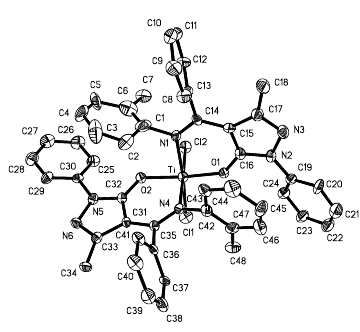
Figure 1. Molecular structure of Ti complex 2 with thermal ellipsoids drawn at the 30% probability level. Hydrogen atoms and toluene were omitted for clarity.